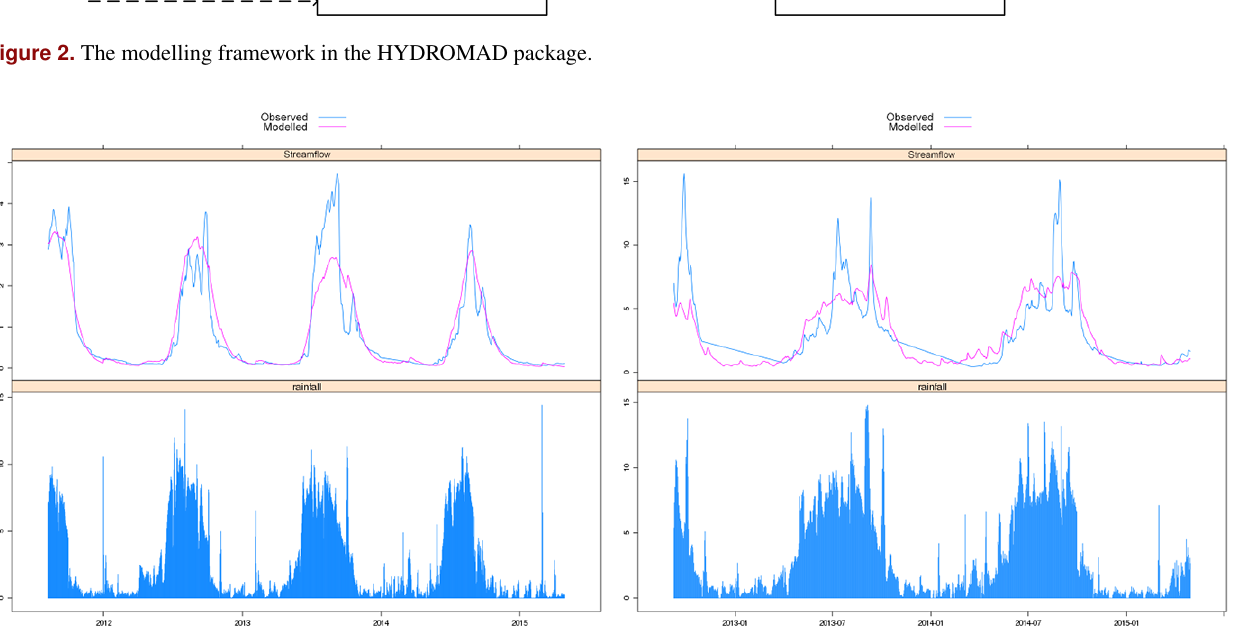
Figure 3. Observed and simulated discharge of without correction (Ganges-left and